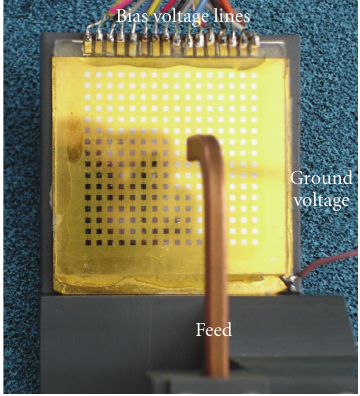
Figure 13: Fully assembled 77GHz LC reflectarray with feed.